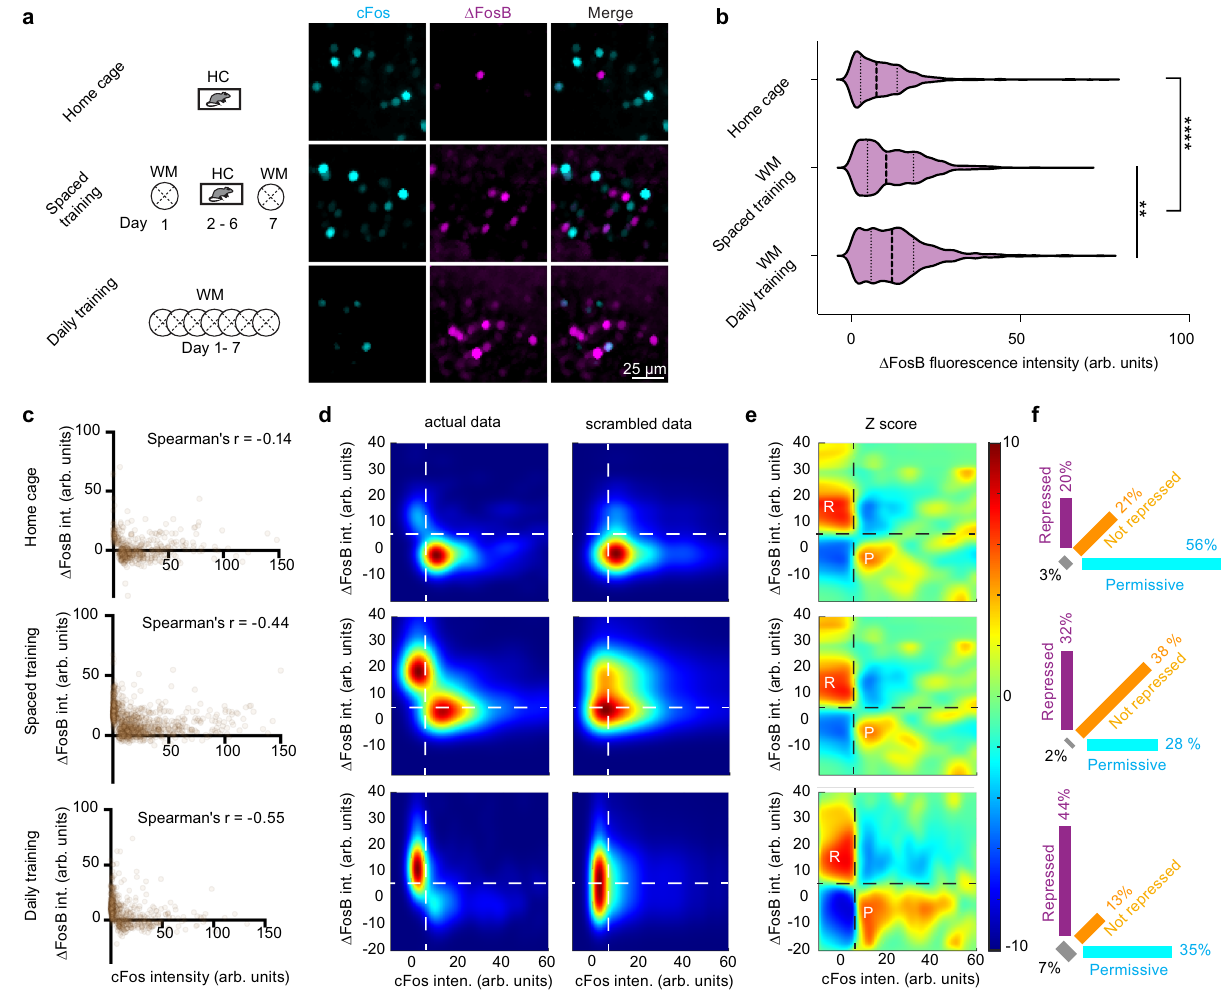
Fig. 8 | Water maze training leads to accumulation of Δ FosB and cFos repres- sioninDG.a Δ FosB(magenta)andcFosexpression(cyan)inDGwasanalyzedafter 3differenttrainingregimes:Home-caged (HC)mice,spacedtraining(ST)anddaily training (DT). Δ FosB images show the difference in fl uorescence between anti- bodies against the N-terminal and the C-terminal region of FosB (see Supplemen- taryFigure10). b Watermazetrainingsigni fi cantlyincreased Δ FosBingranulecells (GC)fromDG( fl uorescenceintensityfrom4imagespermouse.HC:2mice, n =514 GCs; ST: 2 mice, n =1535 GCs; DT: 3 mice, n =1344 GCs). Violin plots showing a rangeofdatadistribution,median(dashedline),andquartiles(dottedlines). Δ FosB expressionincreasessigni fi cantlywithspatiallearning(**** p <0.0001HCvsST/DT) Δ FosB expression is signi fi cantly higher in DT vs ST mice (** p =0.009) Kruskal – Wallis with multiple comparisons Dunn test. c Single-cell analysis of